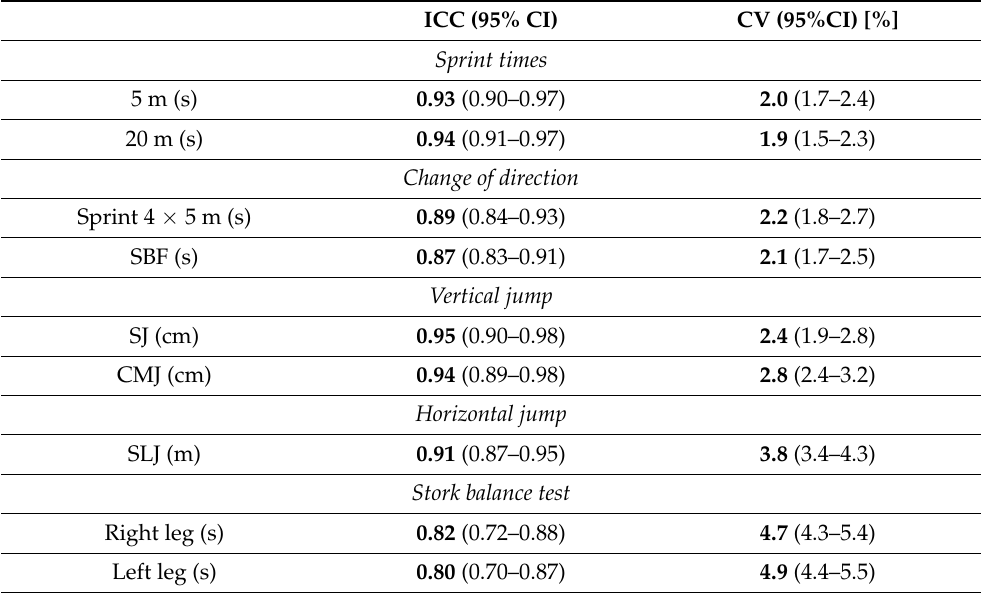
Table 3. Interclass correlation coefficient (ICC, 95% confidence intervals (95% CI)) and coefficient of variation (CV) showing acceptable reliability for all performance. ICC > 0.75 and CV < 10% marked in